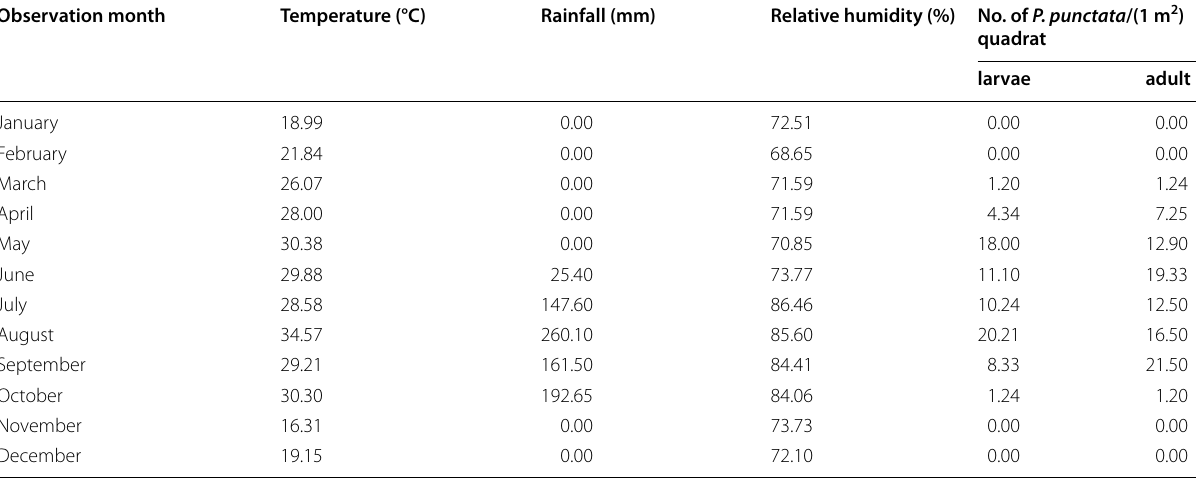
Source : Meteorological station, Regional Station, BRRI, Barishal